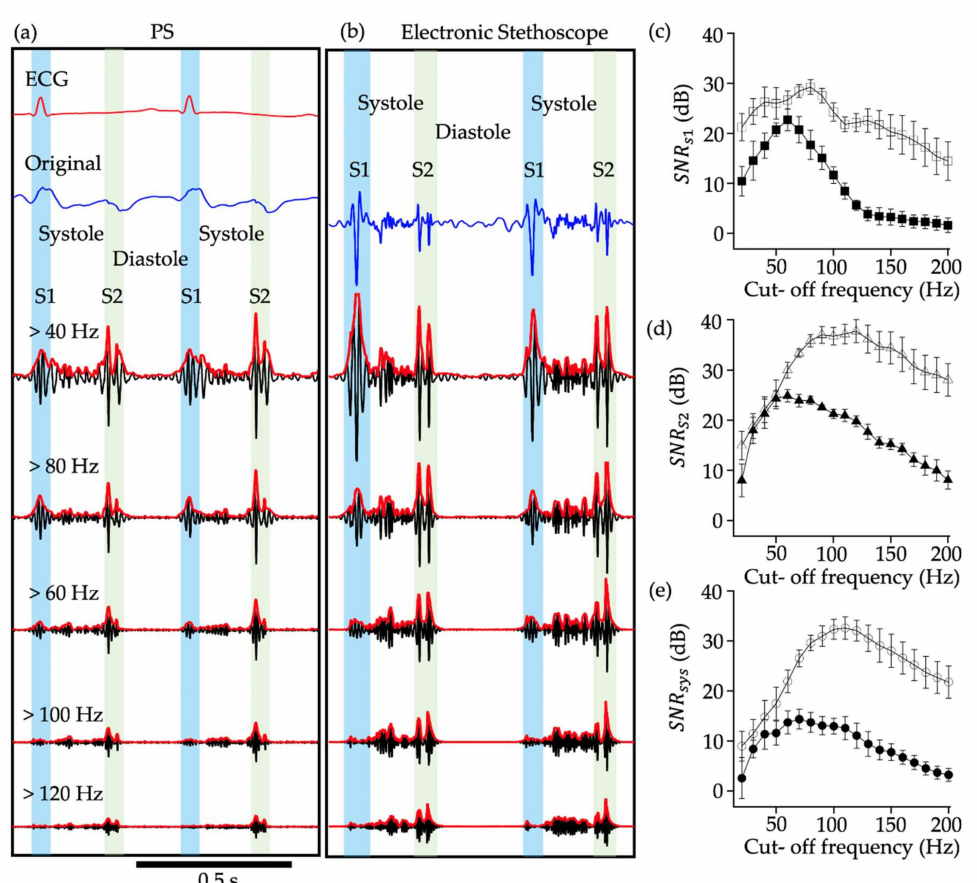
Figure 3. Piezoelectric sensor (PS waveforms and heart sound signals with various cut-off frequencies. ( a ) PS outputs filtered by high-pass filtering with various cut-off frequencies indicated by numerals. The first (S1) and second (S2) heart sounds were distinguished by ECG signals. The red waveform represents the envelope of the filtered signals. Electrocardiogram (ECG) signal was shown on the top and the blue wave form represents the original output. ( b ) Output of electronic stethoscope. There is no simultaneous recording ECG signal. ( c )–( e ) The relationship between SNR s1 ( c ), SNR s2 ( d ), and SNR sys ( e ) are presented. Filled and open symbols indicate the data for PS and electronic stethoscope, respectively. Each point indicates the mean and standard error of 10 consecutive heart beats. SNR sys , signal-to-noise ratio during systole; SNR s1 , signal-to-noise ratio during S1; SNR s2 , signal-to-noise ratio during